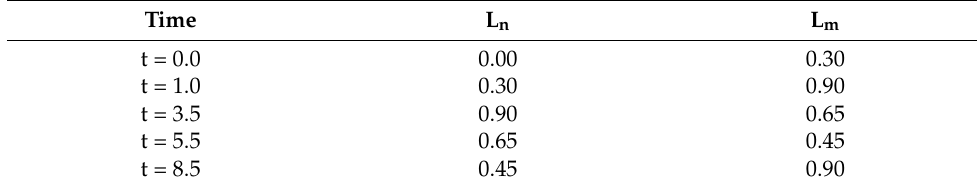
Table 1. Step-Load Utilization